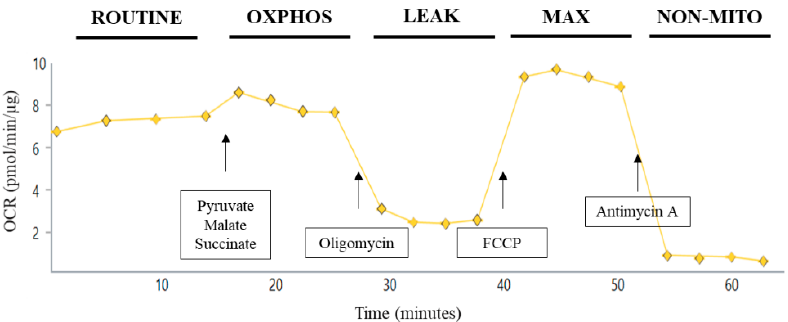
Figure 1. Substrate/inhibitor injection protocol for Seahorse assay of intact platelets. Utilizing the Seahorse XFe96 Flux Analyzer enables the assessment of up to 30 independent samples in triplicate at one time. For respirometry of intact platelets, platelets were added in prostacyclin/phosphate/glucose buffer; this state of respiration is defined as ROUTINE. For injection A, 5 mM pyruvate, 2.5 mM malate, and 10 mM succinate were added to give OXPHOS CI+CII of platelets. Oligomycin (5 µ M) was injected next to give LEAK platelet respiration. FCCP (4 µM) was then added in injection C for MAX CI+CII . Finally, non-mitochondrial (NON-MITO) oxygen consumption, independent of the electron transport system, is measured after addition of antimycin A (1µm).